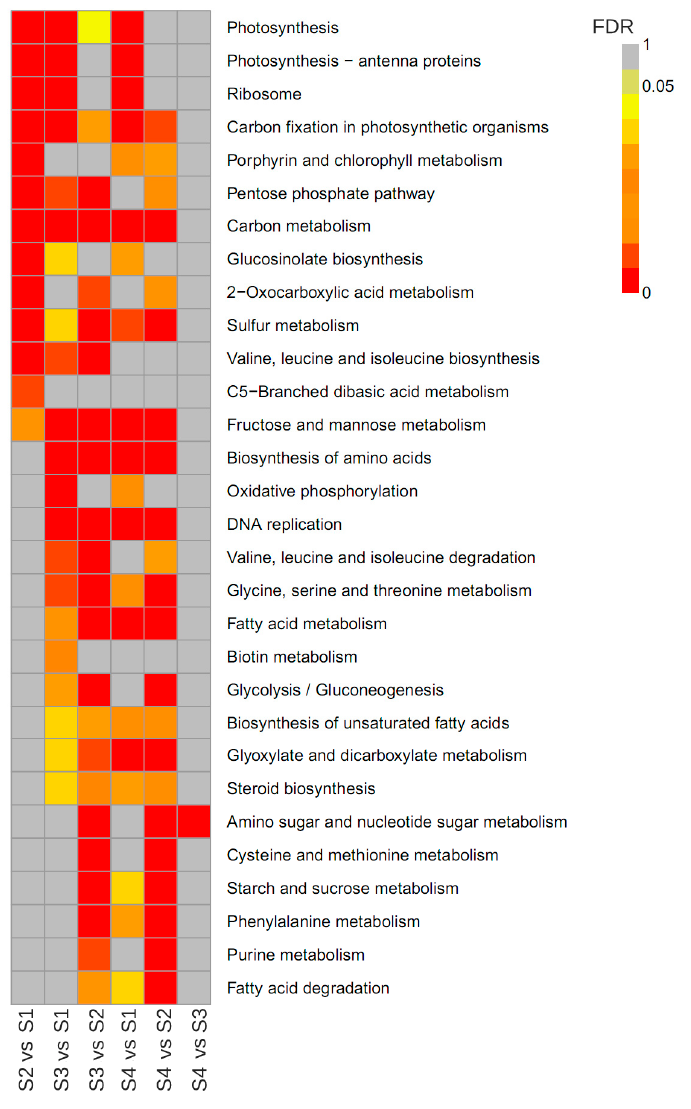
Figure 6. Kyoto Encyclopedia of Genes and Genomes (KEGG) enrichment analysis of DEGs was compared among comparison pairs. The map was made according to q -value of enrichment degree in the pathways, and the redder the color, the more significant the enrichment. The top 30 enriched pathways are represented. Significant DEGs were determined according to false discovery rate (FDR) ≤ 0.05 and (|log2 ratio| ≥ 1).